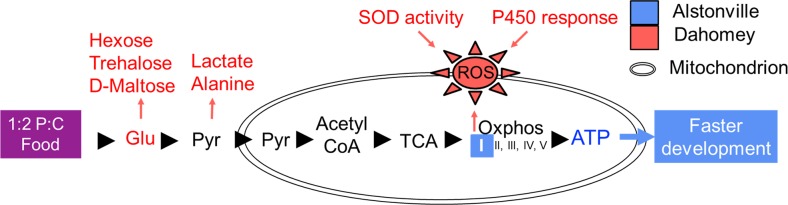
Proposed metabolic differences between Drosophila larvae fed the 1:2 P:C food.Development time for Alstonville larvae was faster than Dahomey because the V161L ND4 mutation in Dahomey caused reduced flow through the electron transport system. Red indicates elevated in Dahomey, blue higher in Alstonville. The mutation created a backup of glucose, which was likely metabolised to hexose, trehalose, and D-maltose. Lactate and alanine were also elevated. The mutation also caused an increase in ROS production, which resulted in an oxidative stress P450 response (including elevated levels of GstE1 and GstE5), high SOD activity and a decrease in ATP level.